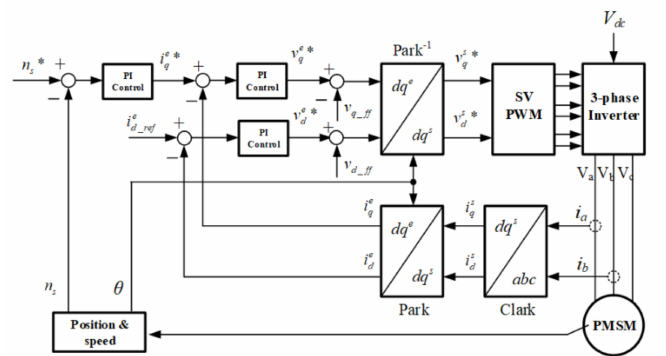
Figure 6. Dynamic simulation block diagram.